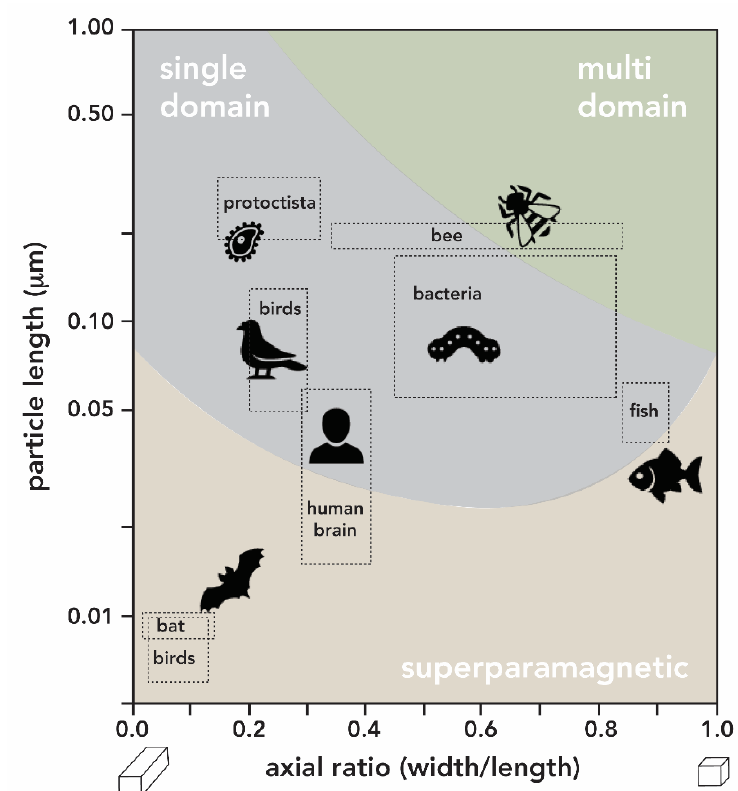
Figure 24. Magnetite in living systems subdivided as a function of particle size and magnetic behavior (single domain, multi domain or superparamagnetic). Adapted from [163] with permission from Springer Nature. Information on additional species was compiled from [164].